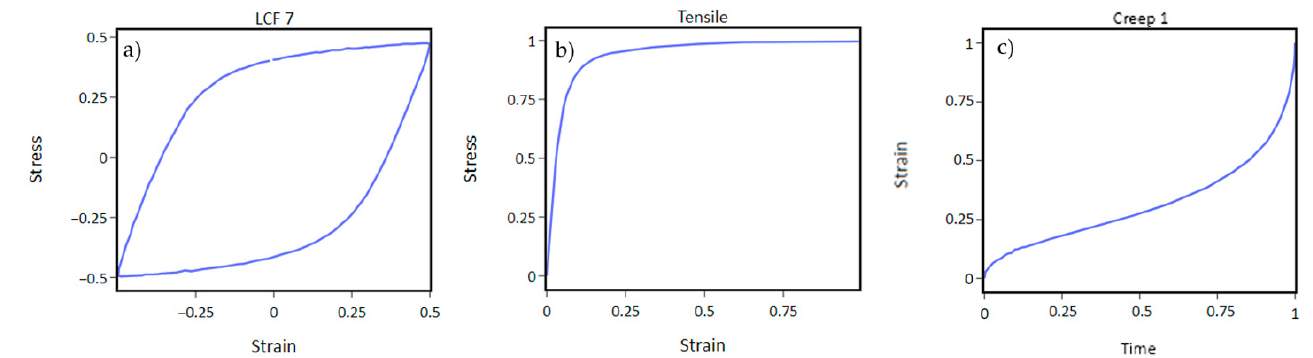
Figure 1. LCF ( a ), tensile ( b ), and creep ( c ) experimental data used for the